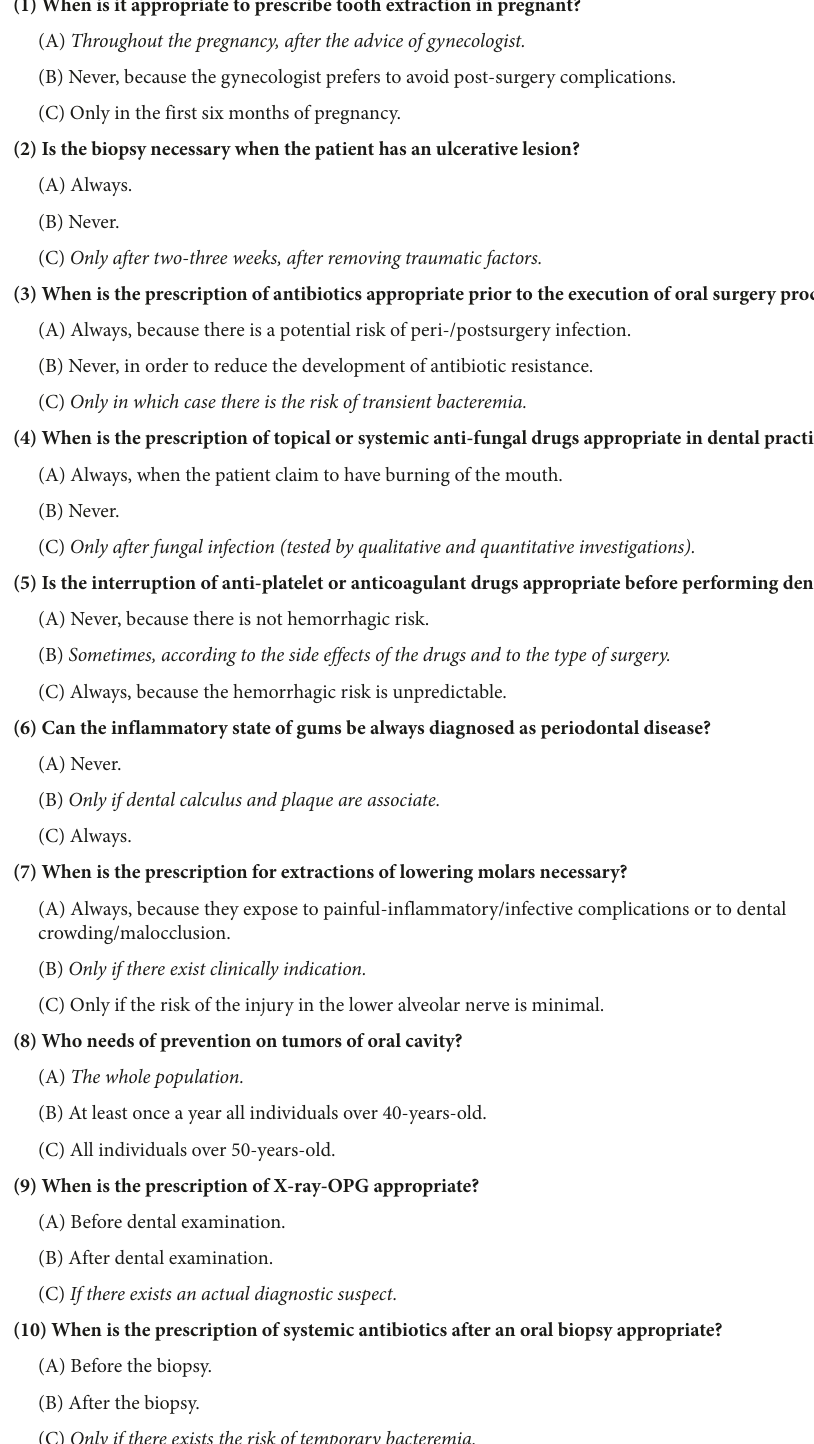
Figure 1: Sample of the administered survey (Items 1–10) with the correct answer